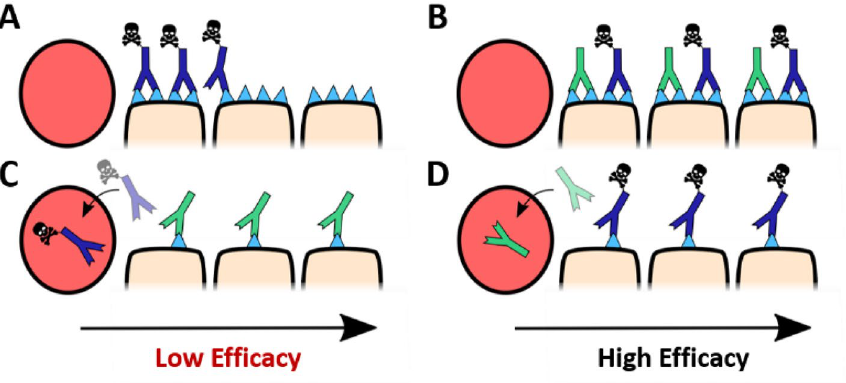
Figure 1. Improving ADC distribution through coadministration of HALA antibody carrier doses. Administration of an ADC (single agent) produces heterogeneous perivascular distribution due to rapid binding relative to transport in the tissue in high expression tumors (e.g. at 3.6 mg/kg for Kadcyla, ( A ). Tumor penetration is improved when the ADC is co-administered with a saturating dose of unconjugated antibody (e.g. 8:1 ratio of antibody to ADC, ( B ). The two antibodies compete for binding sites increasing ADC penetration. However, in low expression systems, unconjugated antibodies can outcompete the ADC ( C ), lowering efficacy. Coadministration of a HALA antibody allows competition in high expression systems ( B ) while enabling the ADC to outcompete the HALA antibody in low expression systems ( D